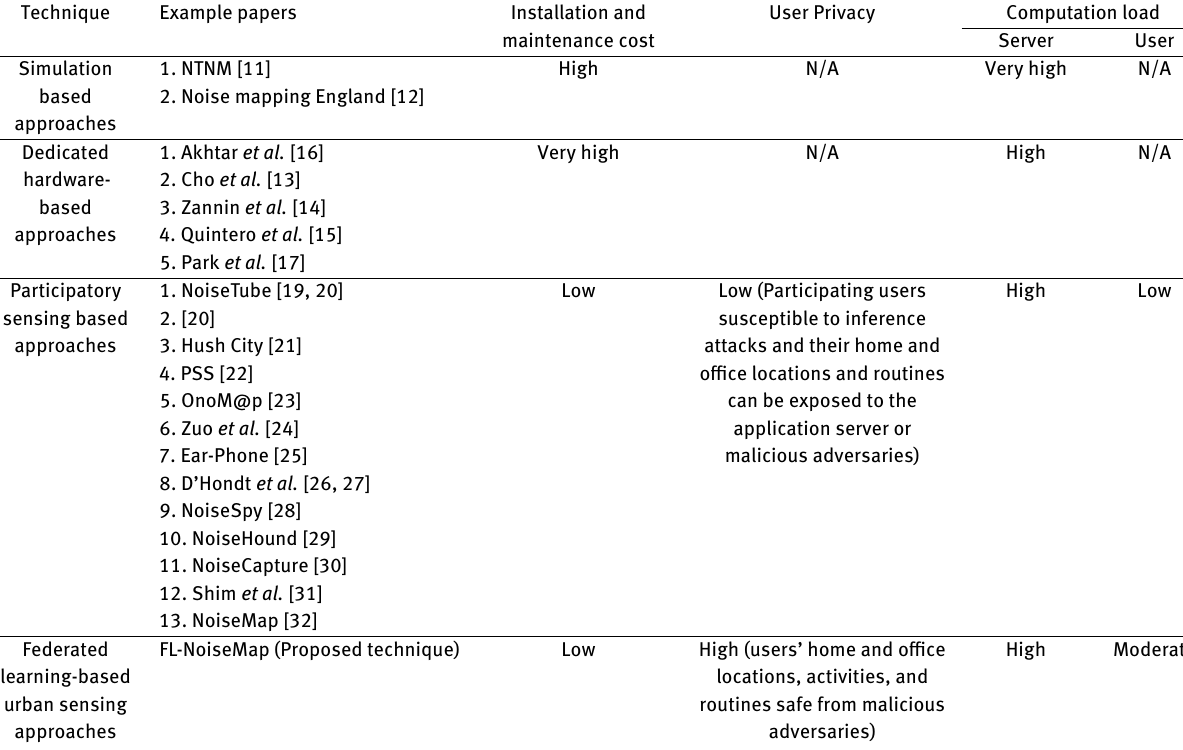
Table 1: Comparison of various urban noise mapping techniques proposed in the literature